Question: Looking at the figure, what chart type is it?
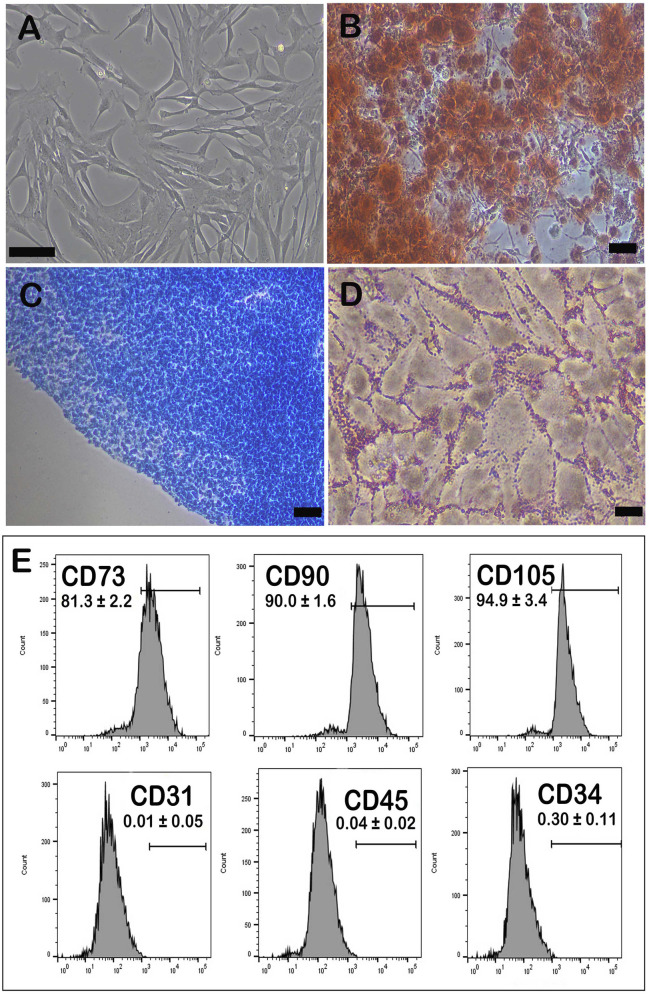
Answer: histogram